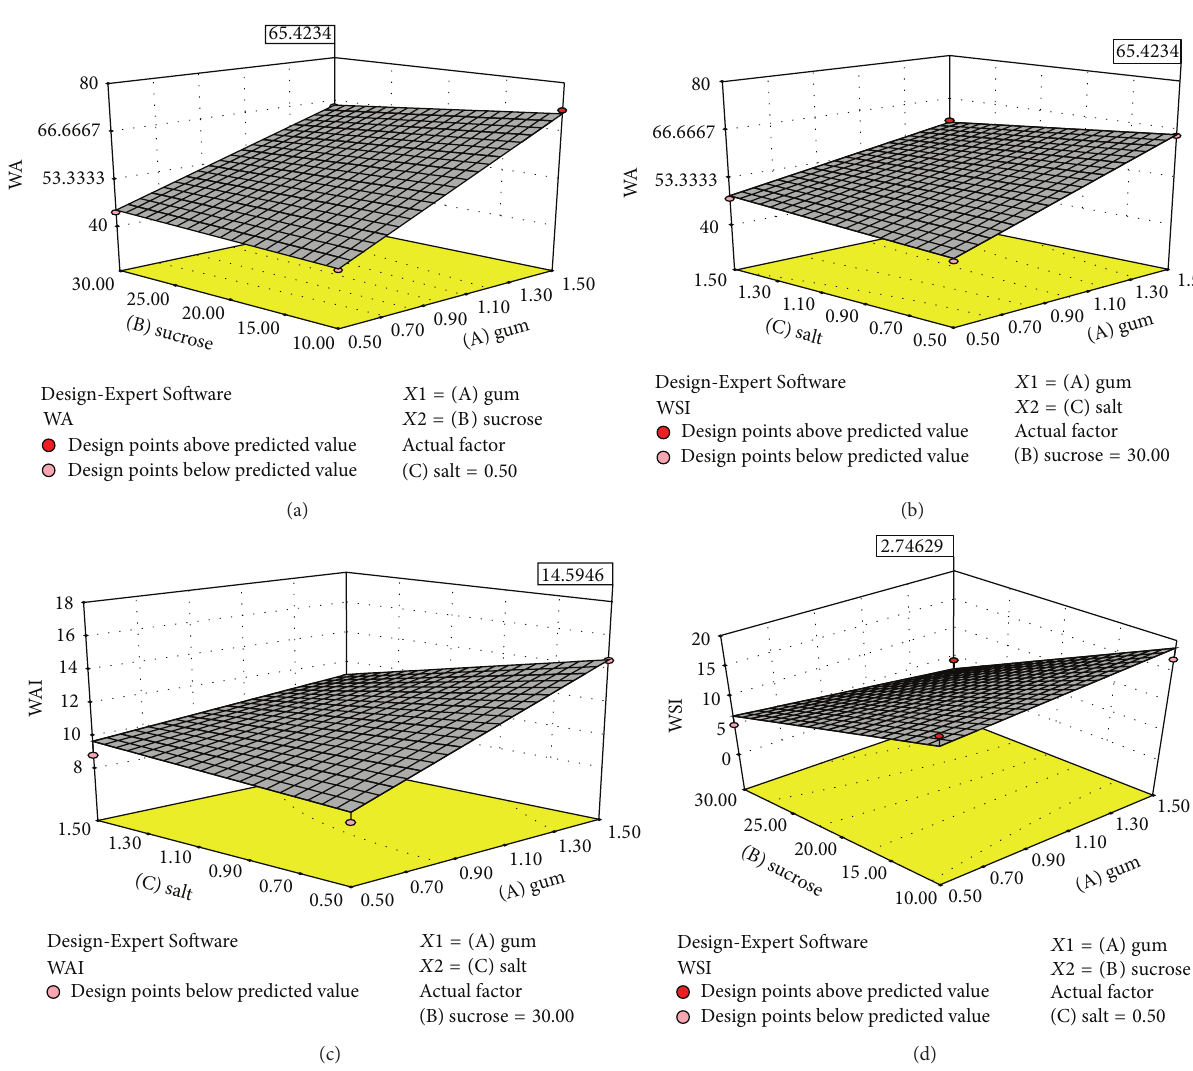
Figure 1: 3D plots depicting effect of (a) sucrose (B) and acacia gum (A) on water absorption of lotus stem starch; (b) NaCl (C) and acacia gum (A) on water absorption of lotus stem starch; (c) NaCl (C) and acacia gum (A) on water absorption index; and (d) sucrose (B) and acacia gum (A) on water solubility index of lotus stem